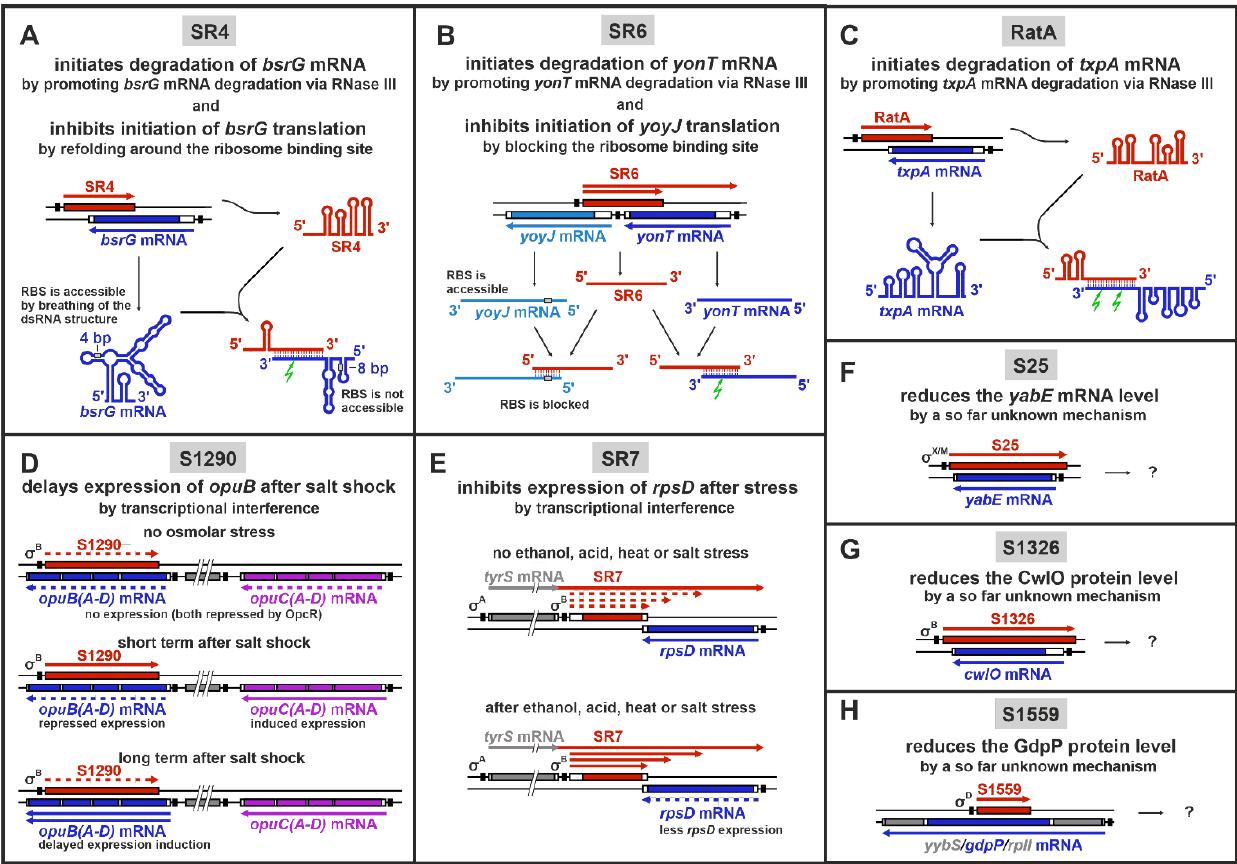
Figure 1. Overview of cis -encoded sRNAs in Bacillus subtilis and their mechanisms of action. ( A ) SR4 is a bifunctional antitoxin: It promotes the degradation of bsrG mRNA and inhibits bsrG translation. The SR5/ bsrE mRNA interaction is highly similar, but SR5 exclusively facilitates degradation of bsrE mRNA; ( B ) SR6 represses two toxin genes by two distinct mechanisms: it inhibits the yoyJ translation and induces the degradation of yonT mRNA; ( C ) RatA promotes txpA mRNA degradation; ( D ) S1290 delays the opuB expression after salt shock by transcriptional interference; ( E ) SR7 reduces the rpsD expression by transcriptional interference under several stress conditions; ( F ) S25 reduces the amount of yabE mRNA; ( G ) S1326 represses the cwlO expression; ( H ) S1559 represses the gdpP expression. The two genomic strands are illustrated as black lines, genes as boxes, and promoter regions as black boxes. The sRNAs and their genes are depicted in red and target genes and mRNAs in blue, other functionally important genes in purple, and unrelated genes in gray; RNaseIII cleavage is represented by a green lightning. In the case of translational inhibition, the RBS is depicted as a grey box.